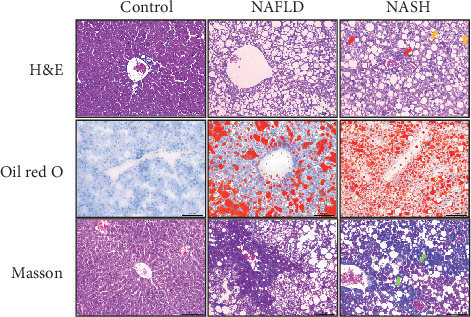
Histopathologic features of C57BL/6 mice on HFD or control diet over 8 months. H&E staining, Oil red O staining, and Masson's trichrome staining were performed. Representative images were amplified 200 times. Hepatocyte ballooning was pointed out by yellow arrows, lobular inflammation was marked by red arrows, and fibrosis was labelled by green arrows. n = 10 for each group.